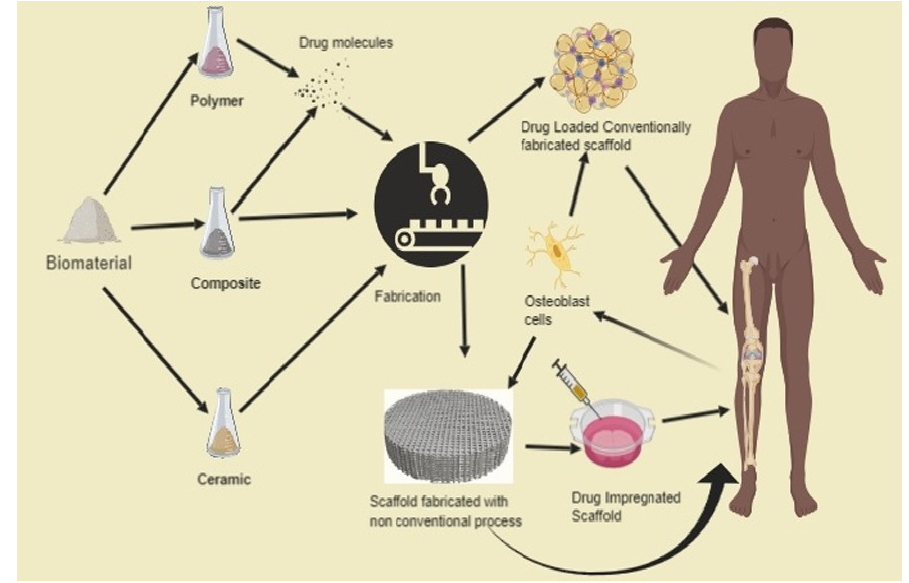
Figure 20. The method in which the scaffold is immersed in the drug solution. Reproduced with permission from [1].